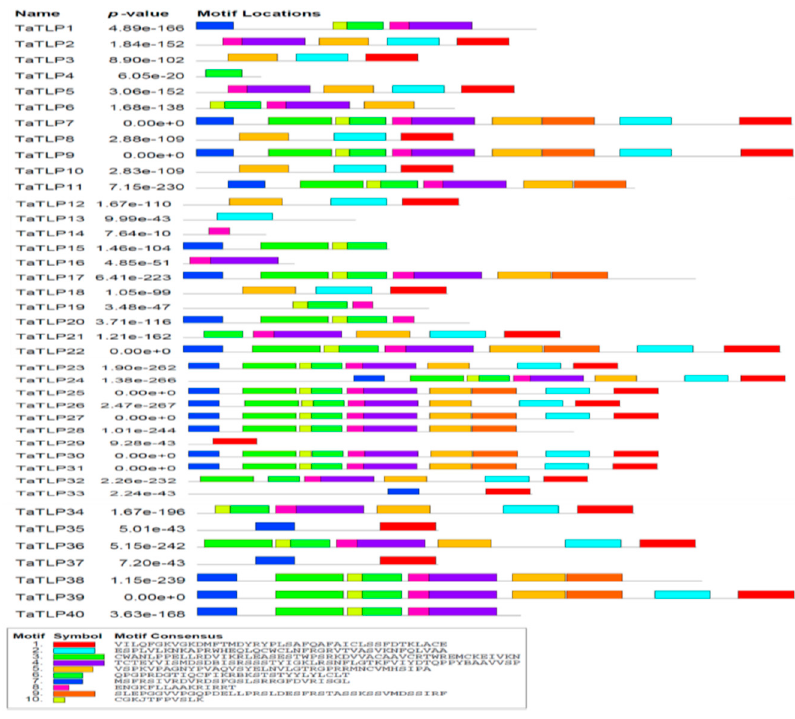
Figure 2. The TaTLP s genes’ conserved motifs.